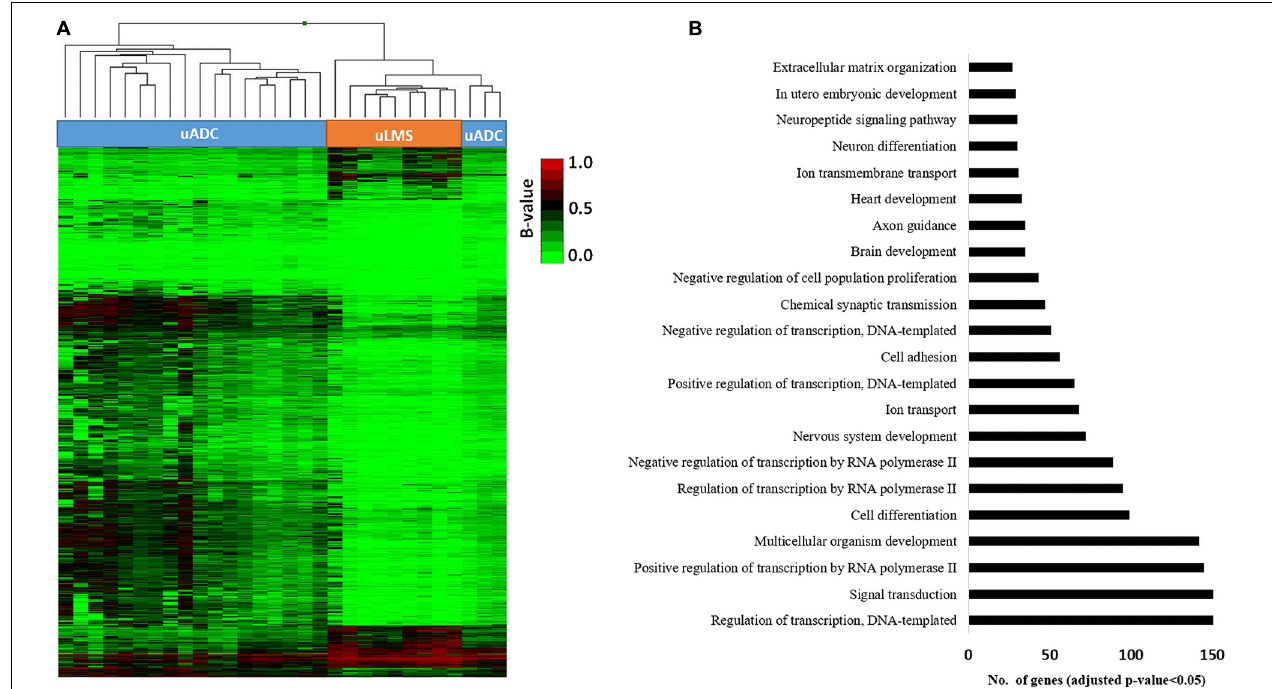
FIGURE 7 | Identification of differential DNA methylation signature of promoter CGIs in invasive tumor front (ITF) of primary uterine adenocarcinomas (uADC) and leiomyosarcomas (uLMS). (A) Supervised hierarchical clustering of the most variable CpGs (2,971 CpGs and 1,253 genes; FDR < 5%) from island and promoter regions between the primary ITF of uADC and uLMS. (B) Gene ontology (GO) analysis of the biological process categories for the 1,253 differentially methylated genes at CpG island and promoters between the primary ITF of uADC and